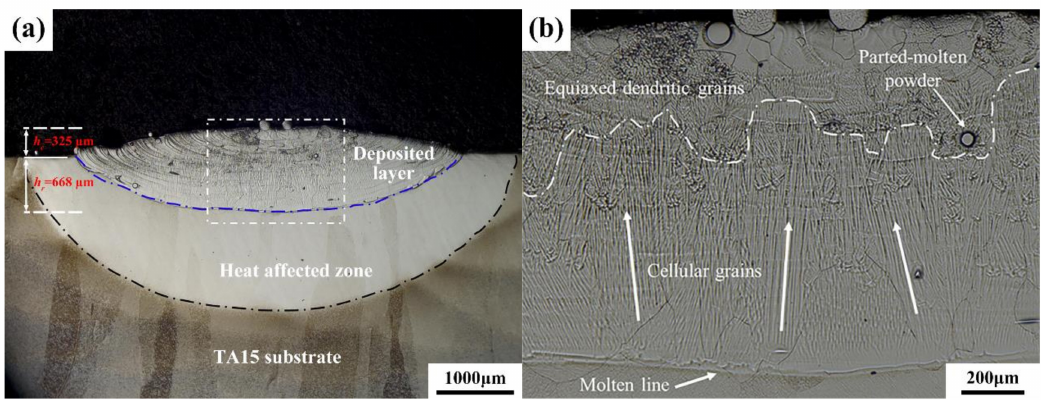
Figure 3. The light microscopy pictures of the cross-section of the first deposited layer in E1: ( a ) macromorphology; ( b ) magnified image of the microstructure in the deposited